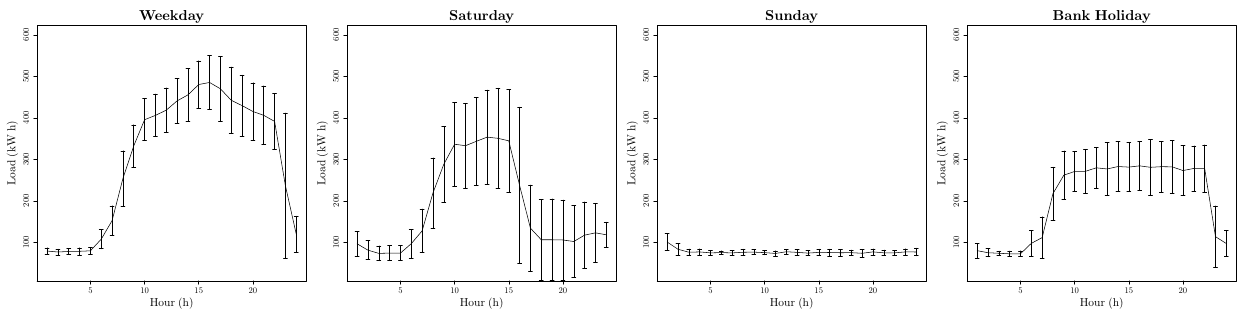
Figure 5. Typical load for the dataset with four day-types. Average daily load ( kW h ). Error bars denotes ± σ . Dataset bilbao 2